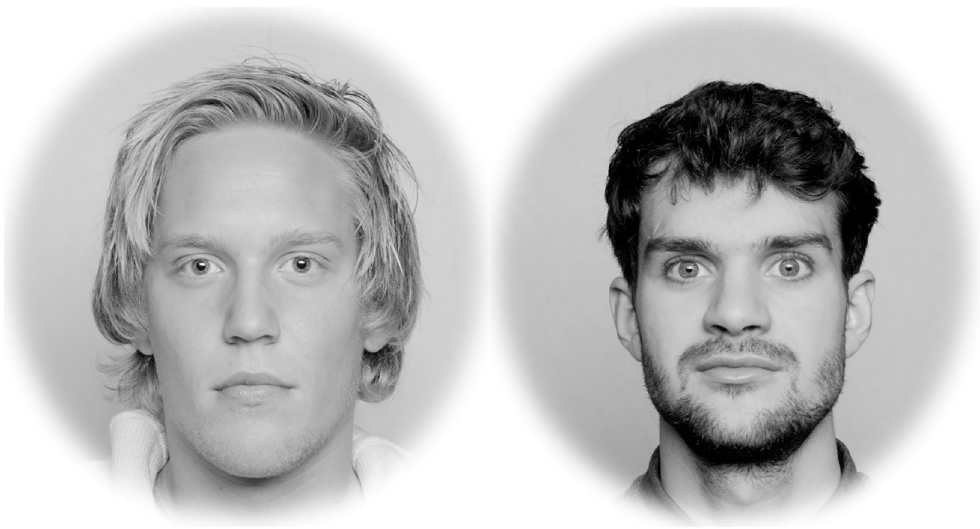
Fig 2. Illustration of a pair of male faces from the Oslo Face Database in the broadband (unfiltered) condition. The task in each trial was to decide by pressing one of two keys which of the two faces looked more attractive.